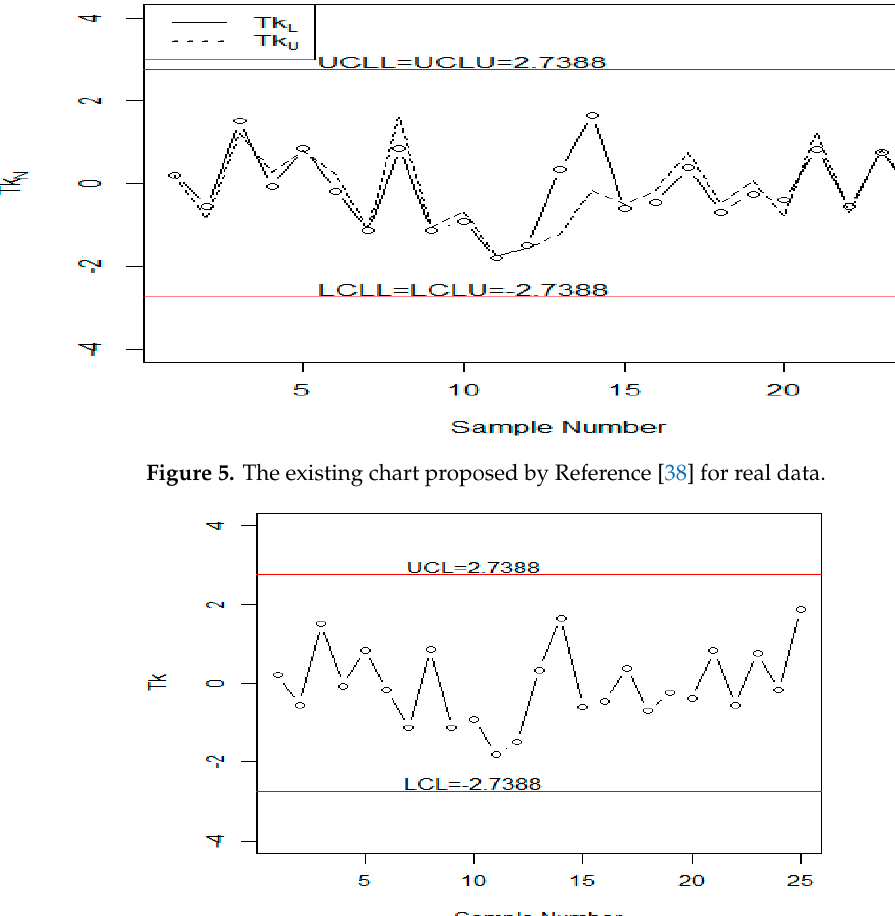
Figure 4. 𝑆 (cid:3015)(cid:2870) − 𝑁𝐸𝑊𝑀𝐴 chart for real data.